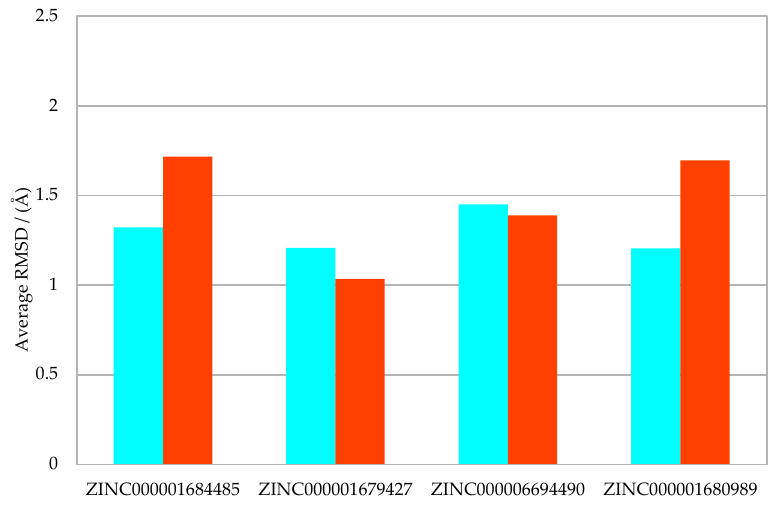
Figure 3. Average RMSD values between protein/protein (orange) and ligand/ligand (cyan).